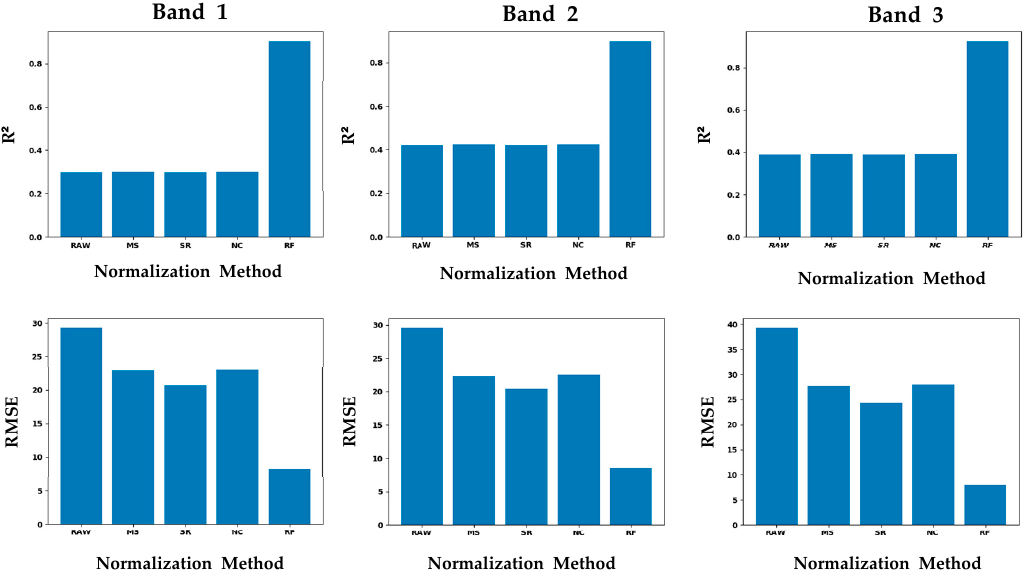
Figure 8. Comparison of R 2 and RMSE for the raw image and normalized subject image generated by different linear regressions and RF regression.